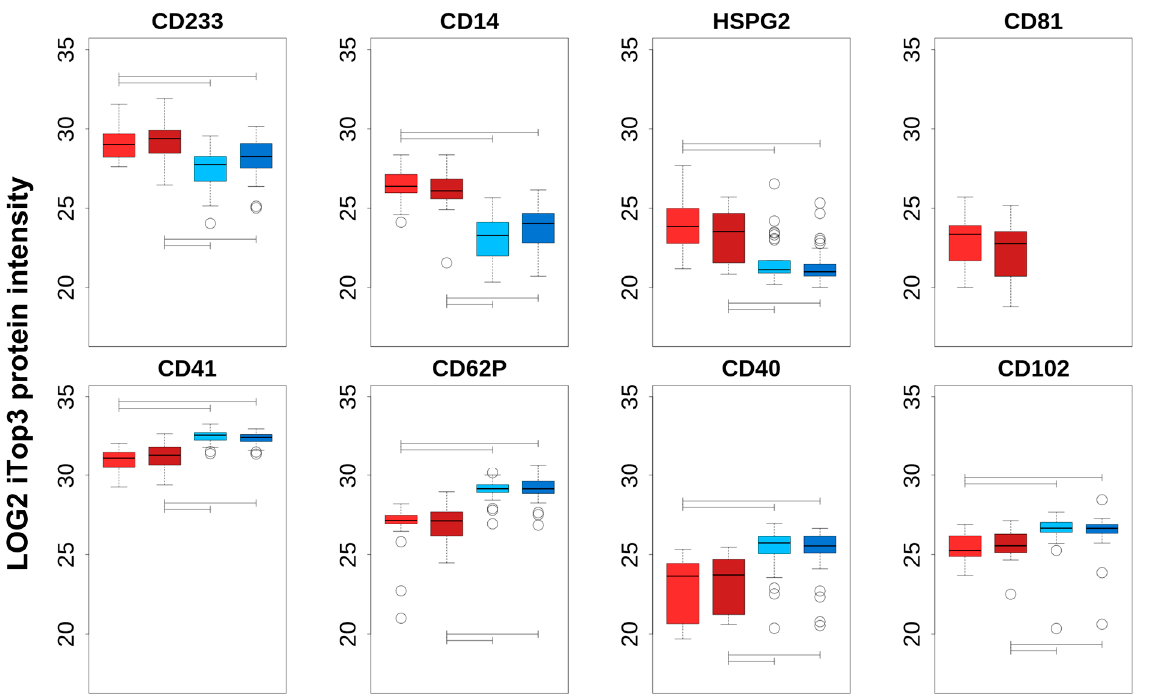
Figure 3. Abundance comparison of cell-type-specific proteins. Each boxplot shows, on the same scale, the spread of log2 iTop3 intensities of cell-type-specific proteins (indicated above the plot), for, from left to right, PFP_C (light red), PFP_PTS (dark red), PPP_C (light blue), and PPP_PTS (dark blue). Segments within the plots indicate when the one-way ANOVA post hoc pair-wise tests between the groups were significant ( p ≤ 0.01). Protein intensities from all the samples have been normalized together. The top row of plots presents cells that were enriched in PFP with erythro- cytes represented by CD233 , macrophages by CD14 , endothelial cells by HSPG2 , and CD81 being a more ubiquitous marker that is generally considered to represent exosomes. The cell-types that are represented in the second row of plots is platelets with CD41 and CD62P , and lymphocytes and monocytes with CD40 and CD102 , respectively.